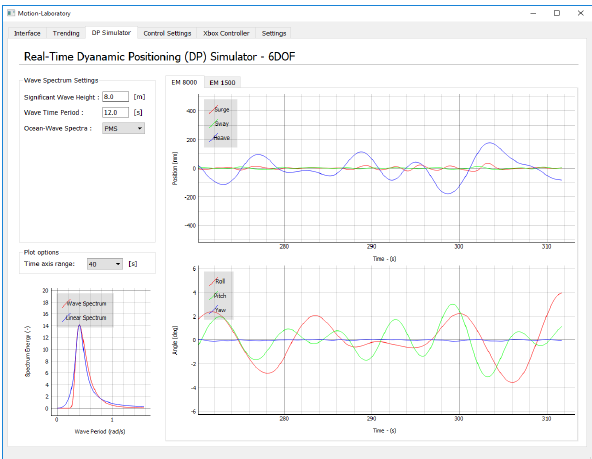
Figure 11: Monitoring tab of the HMI with updating displays and graphical plots.